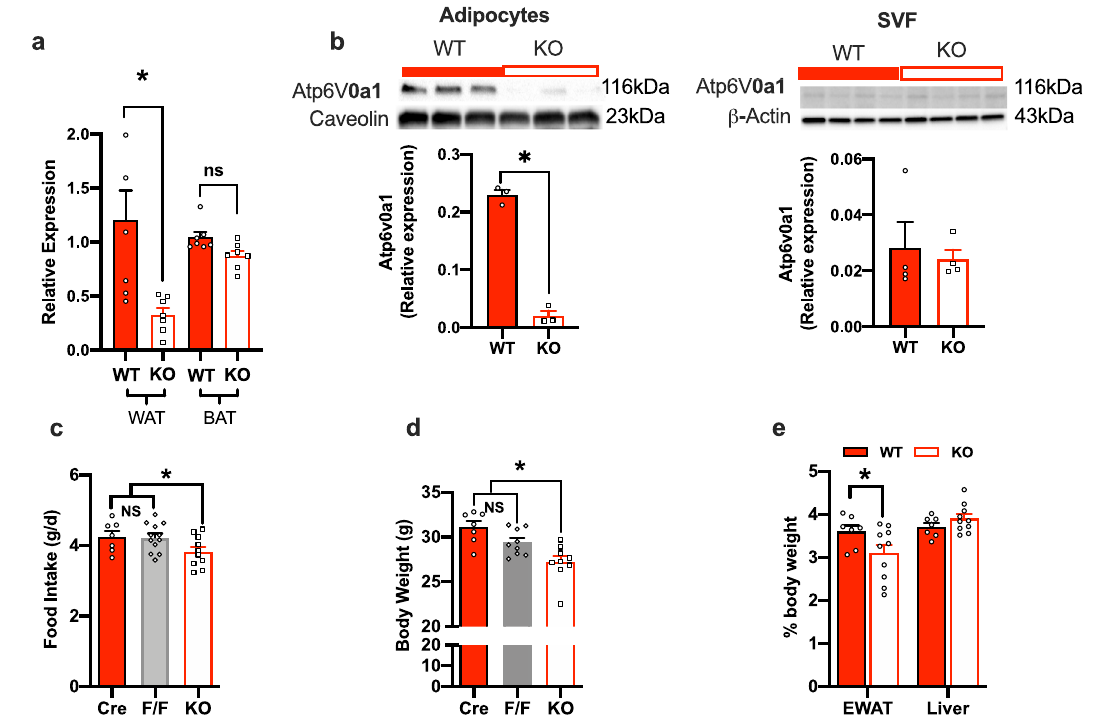
Fig. 3 | Adipocyte-speci fi c Atp6v0a1 depletion in vitro and in vivo. Atp6v0a1 mRNAquanti fi cationinWATandBAT( f =7.221,df=3, p =0.0013)adiposetissuein KO (white bars) and WT controls (red bars), n =7 per group. b Western blots and densinometric quanti fi cation of Atp6V0a1 in adipocytes ( t =16.86, df=4, CI= − 0.244to − 0.175, p <0.001)andSVCs( t =0.41,df=6,CI= − 0.028to0.02, p =0.34) from gonadal WAT from WT (adiponectin Cre) and KO mice ( n =3 –